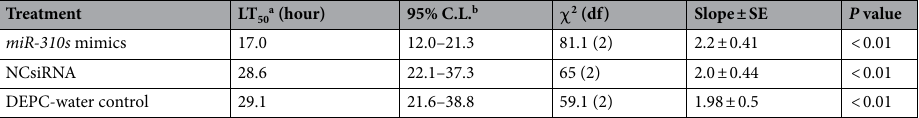
Table 1. Evaluation of DDT sensitivity in Drosophila 91-R strain after miR-310s mimics injection using a topical exposure to DDT (0.5 µg/fly). a Lethal Time 50 (hour) that killed 50% of the flies. b 95% Confidence limit.